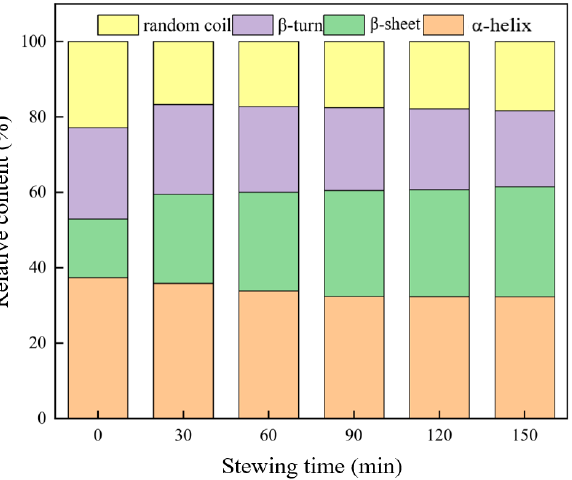
Figure 4. E ff ects of stewing time on the secondary structure of MP in Sichuan − style braised beef. Figure 4. Effects of stewing time on the secondary structure of MP in Sichuan-style braised 3.7. Protein Secondary Structure As shown in Figure 4, the secondary structure of MP in beef changed signi fi cantly with prolonged stewing time. When the stewing time was 0 min, α− helix was the most